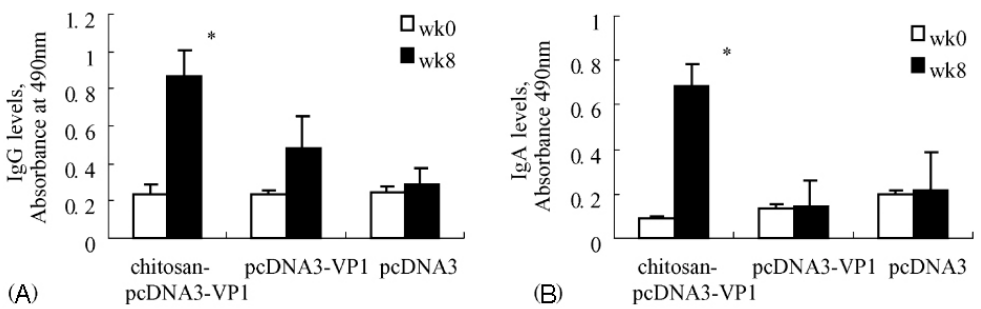
Figure 17. CVB3-specific antibody responses raised by chitosan-pcDNA3-VP1 vaccine. ( A ) Anti-CVB3 IgG responses in serum samples; ( B ) Anti-CVB3 IgA responses in fecal extracts (* p < 0.05) [60].